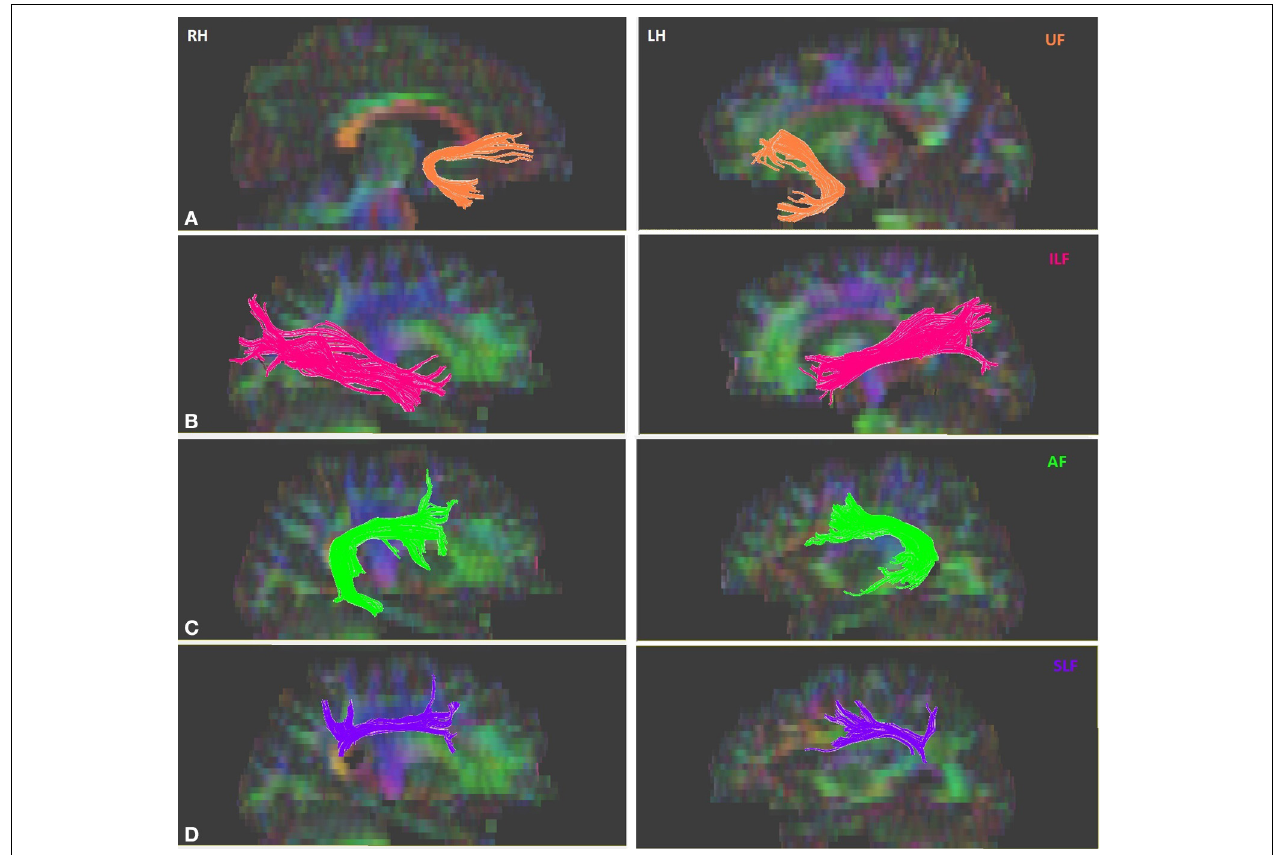
FIGURE 1 | Sample of isolated tracts in the left (LH) and right (RH) hemispheres. (A) Uncinate fasciculus (UF), (B) Inferior longitudinal fasciculus (ILF), (C) Arcuate fasciculus (AF), (D) Superior longitudinal fasciculus